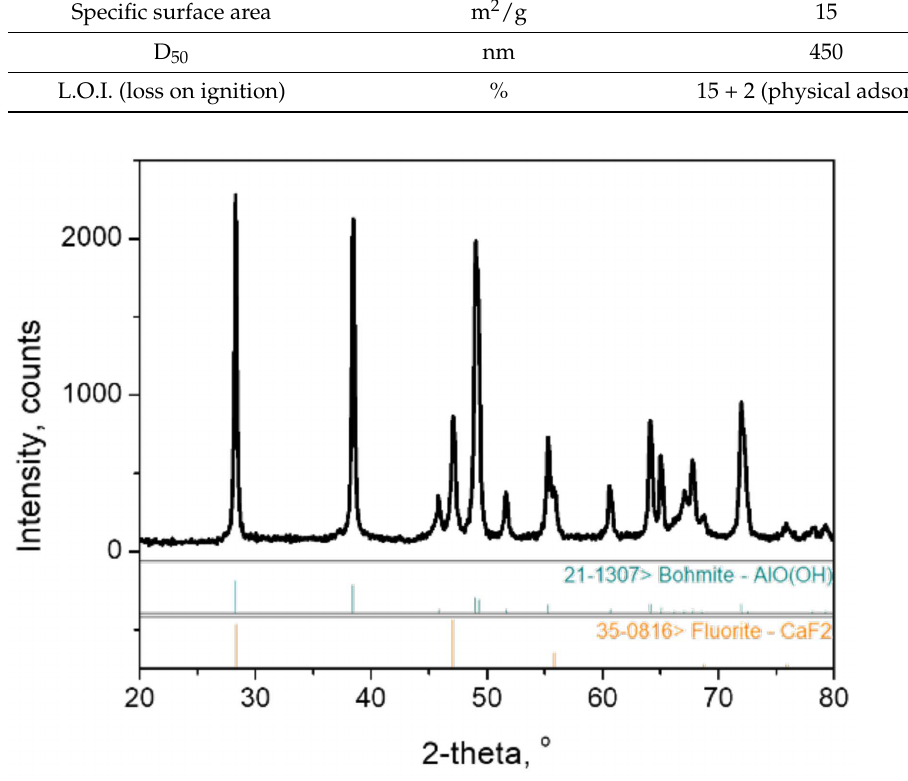
Figure 1. XRD patterns of starting boehmite powders used in this study.